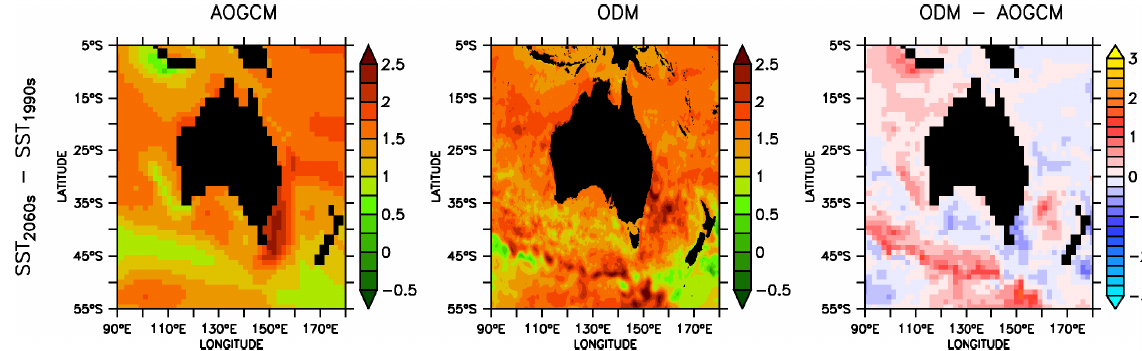
Fig. 8. 10-yr averages of the projected climate change in SST (in ◦ C) from the AOGCM, RELX-ODM, and their difference.